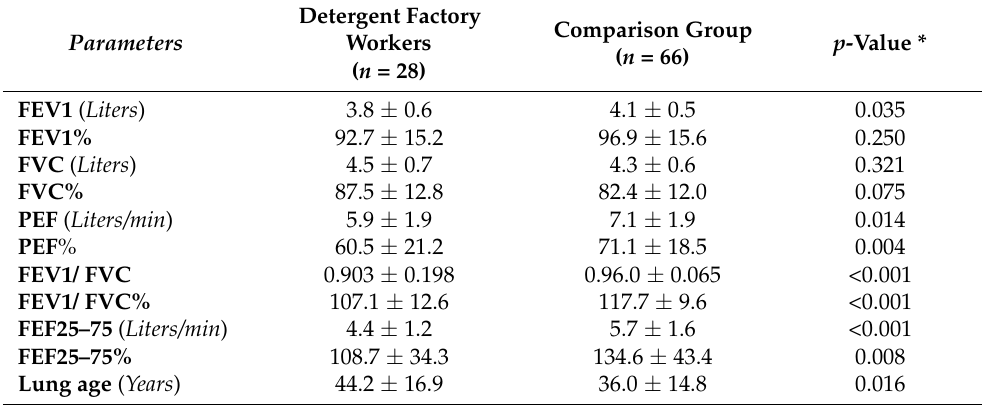
Table 2. Spirometry results of the detergent factory workers and the comparison group. Detergent Factory Comparison Parameters Workers ( n = 28)